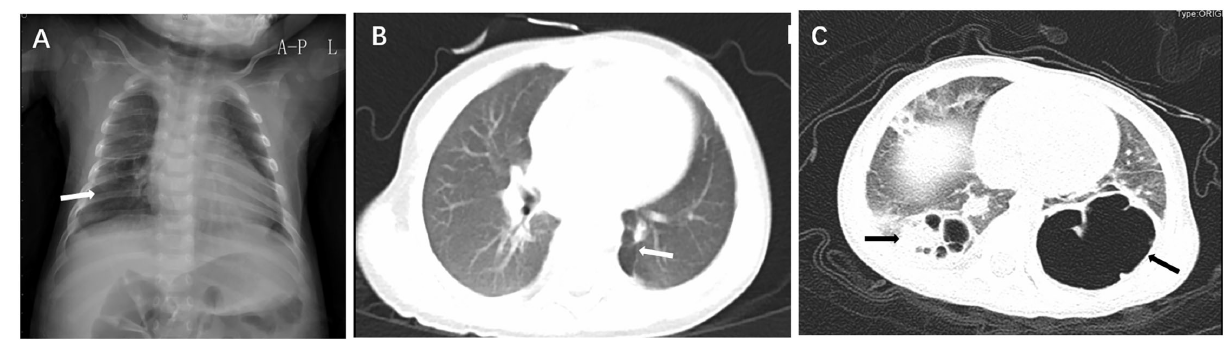
the SOAP website was used to calculate the sequence depth and genomic coverage for each